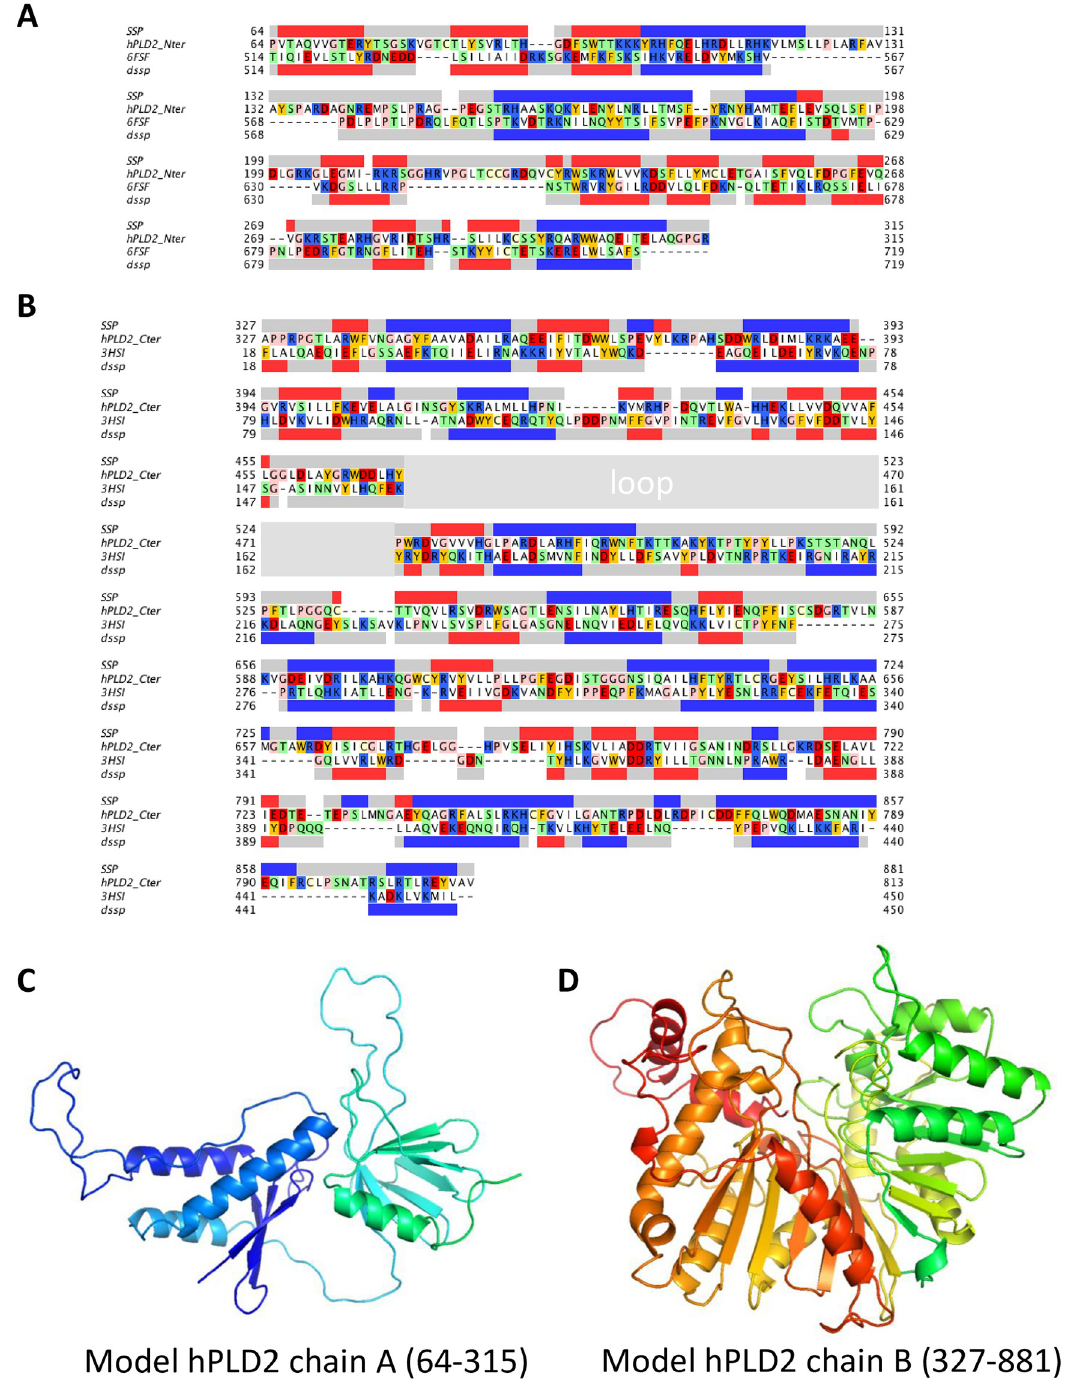
Fig 1. Structural modeling chains A and B of human PLD2. Sequence alignments used to model chains A (residues 64–315) and B (residues 327–881) of human PLD2 (PDB ids: 6fsf and 3hsi). The secondary structure prediction (SSP) for hPLD2 is listed at the top each alignment by grey (coil), red (strand) and blue (helix) bars; the secondary structure from the structure of each template (dssp) is below the sequence. The loop in chain B for which there is no template is indicated with a gray bar. Residues in the sequence are highlighted as follows: basic (blue), acidic (red), polar (green), apolar (white) aromatic (orange), glycine and proline (pink). The final models for chains A and B are shown in C and D in ribbon style.